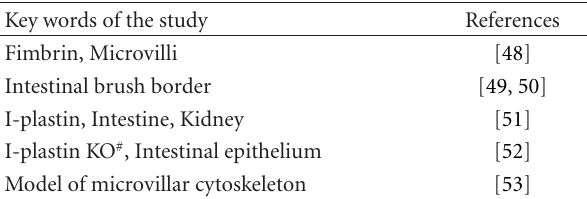
Table 4: Studies on fimbrin/I-plastin in the